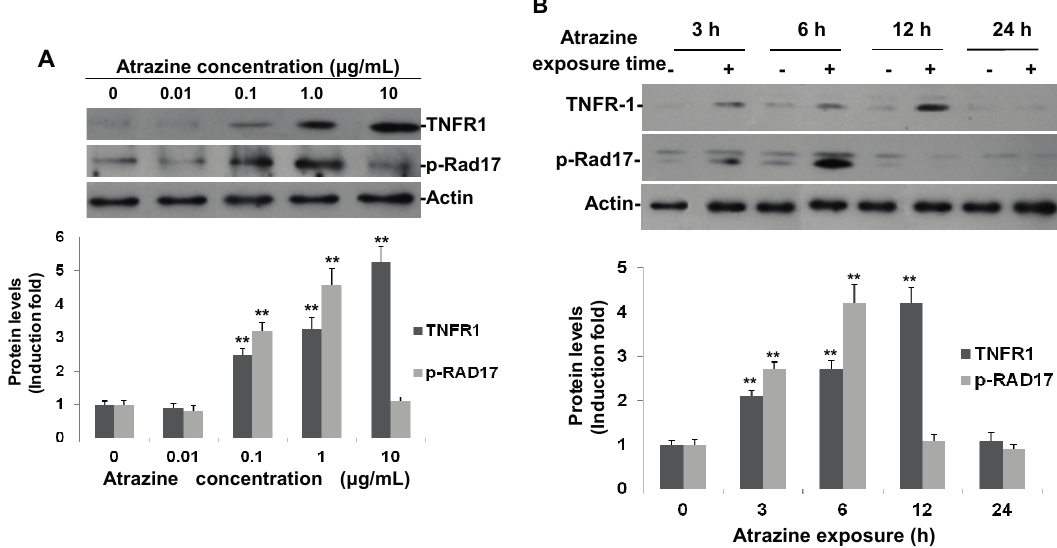
Figure 3. Atrazine induced phospho-Rad17 (Ser635) and TNFR1expression in MCF-10A cells. ( A ) Dose-response of atrazine-induced p-Rad17 (Ser635) and TNFR1. MCF-10A cells (3 × 10 5 ) were incubated with indicated concentrations of atrazine for 6 h and analyzed by Western blot; ( B ) Time course of atrazine-induced p-Rad17 (Ser635) and TNFR1 expression in MCF-10A cells. MCF-10A cells (3 × 10 5 ) were treated with 0.1 μ g/mL of atrazine for the indicated times and analyzed by Western blot. For each blot, the resulting fold-change of atrazine-mediated p-Rad17 and TNFR1 expression over untreated controls is provided in the corresponding histogram ( n = 3) normalized to actin, ** p < 0.01 vs.